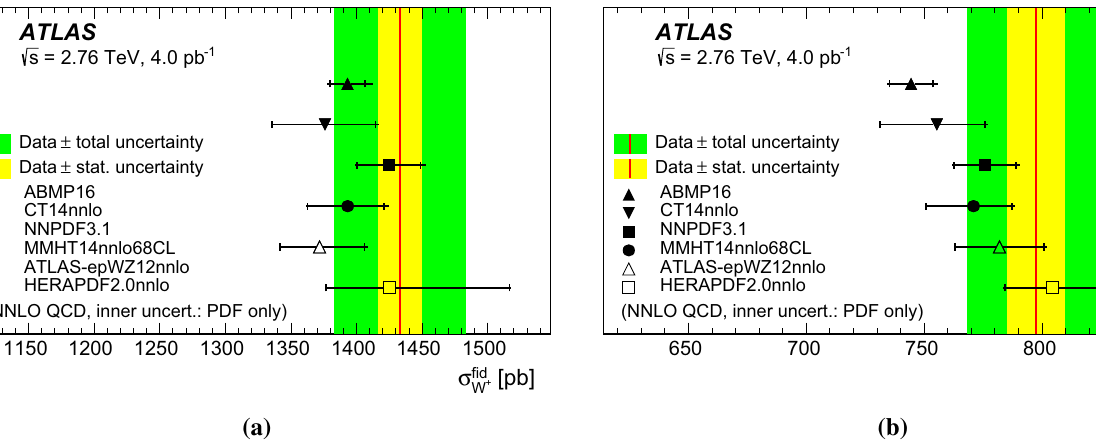
Fig. 5 NNLO predictions for the fiducial cross-section (a) σ fid and (b) σ fid for the six PDFs CT14nnlo, MMHT2014, NNPDF3.1, W − ATLASepWZ12, ABMP16 and, HERApdf2.0 compared with the mea- sured fiducial cross-section as given in Table 7. The inner shaded band